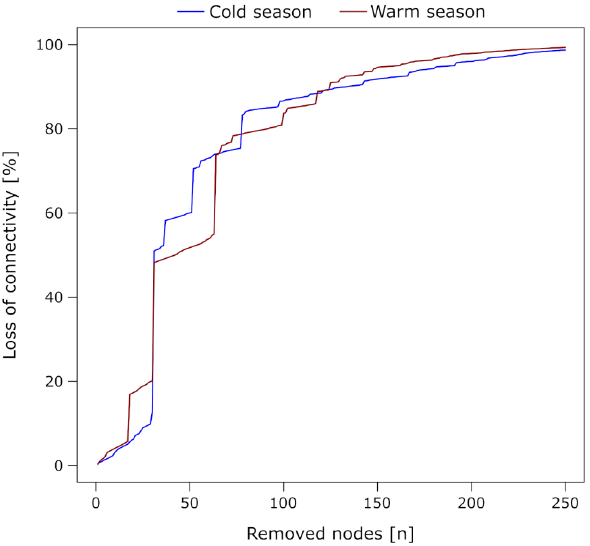
Figure 4. Robustness of the networks in both seasons towards a species extinction scenario. We stepwise removed the nodes with the highest betweenness centrality from the network and recorded the loss of connections (edges) in the network that was caused by this cascading attack. Displayed is the removal of the 250 nodes with the highest betweenness centrality from each network, after which the loss of connectivity was 98.67% in the cold season (blue) and 99.32% in the warm season (red). At this point, the networks had almost completely disintegrated and the removal of more nodes had only little effect. only little